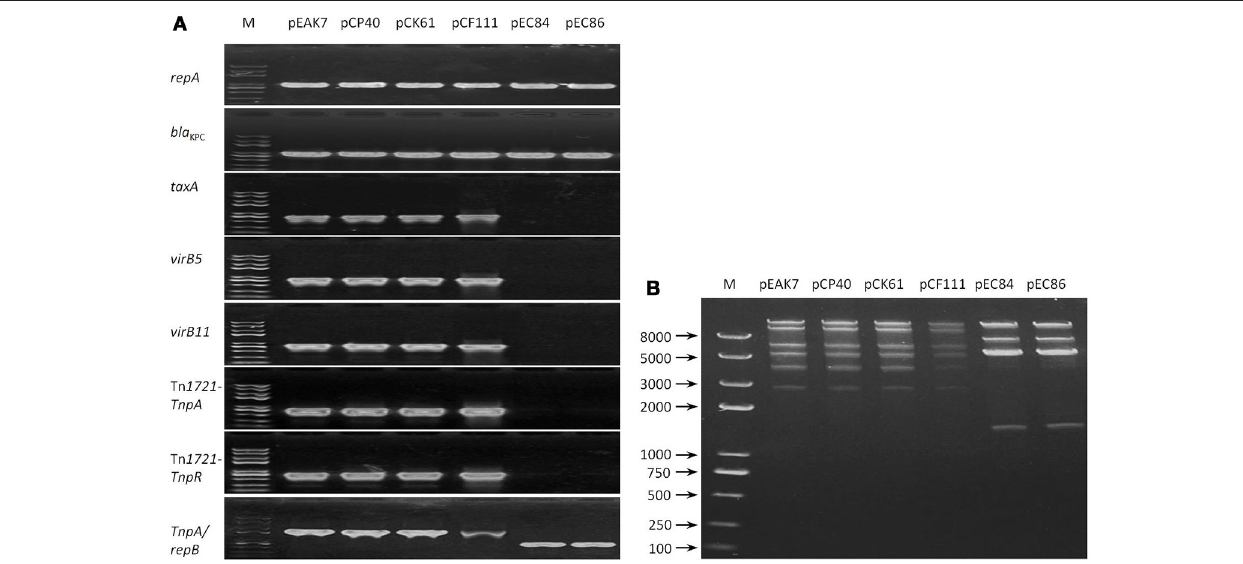
FIGURE 1 | Relatedness of the 6 untypeable plasmids. (A) Mutilocus-PCR results. Primers targeting the genes repA , bla KPC , TaxA , virB5 , virB11 , Tn 1721 - TnpA , Tn 1721 - TnpR , and repB were designed. Two profiles were obtained after evaluation of the amplicons by electrophoresis. The plasmids pEAK7, pCP40, pCK61, and pCF111 exhibited one pattern, while pEC84 and pEC86 exhibited a different pattern. (B) RFLP results. Fragments were separated by electrophoresis on a 1% agarose gel in 1 × TAE buffer. Two different patterns, one for the plasmids pEAK7, pCP40, pCK61, and pCF111 and another for pEC84 and pEC86, were obtained.